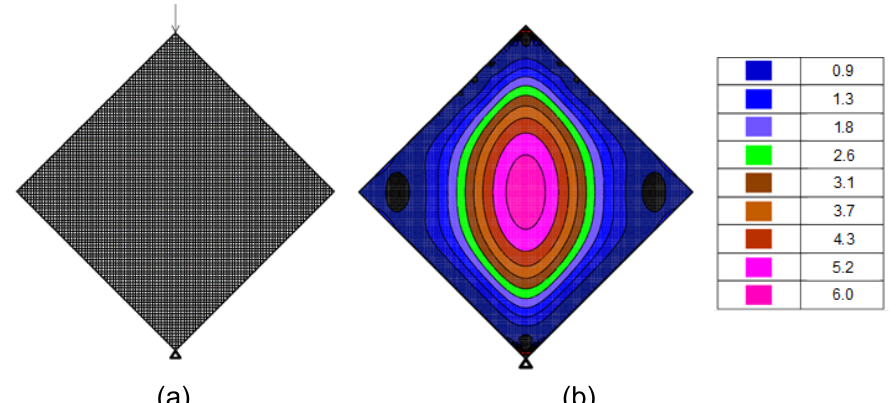
Figure 7. ( a ) Finite element model of a 800 × 800mm 2 specimen and ( b ) resulted contour of maximum principal stresses [ × 10kPa] under a 10kN